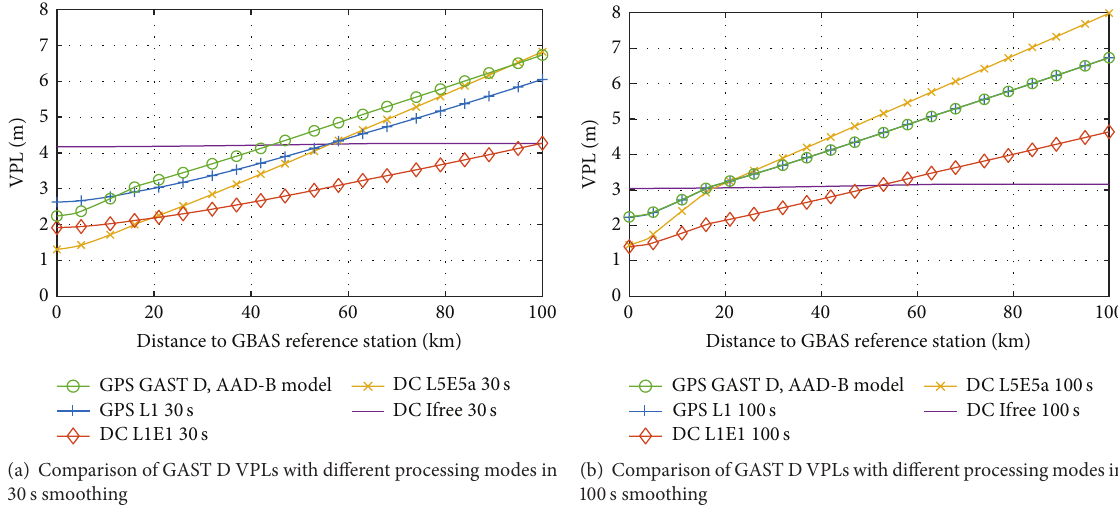
(b) Comparison ofGAST DVPLswith different processingmodes in 100s smoothing Figure 14: Comparisons of H0 VPL over distance for sets of different processing